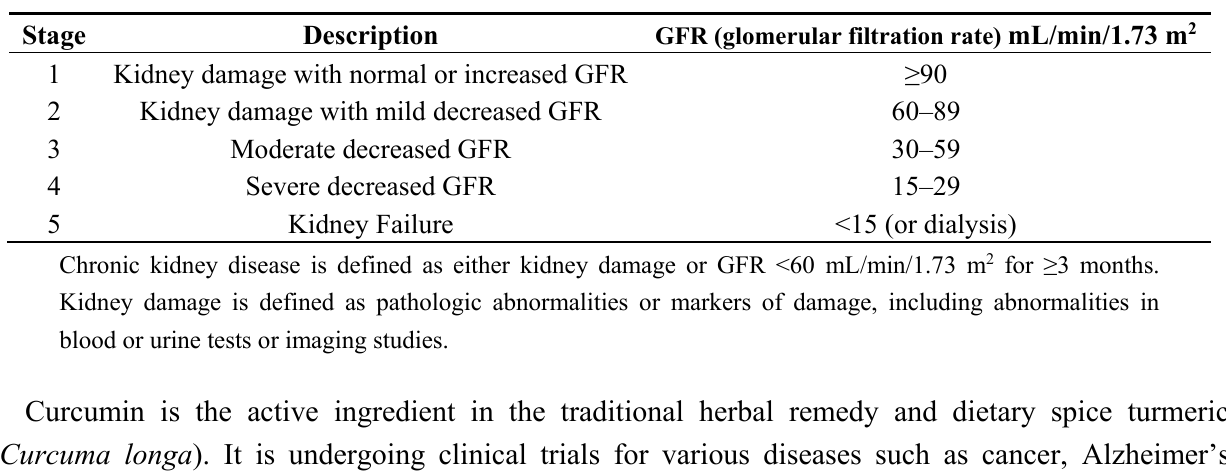
Table 1. Stages of chronic kidney